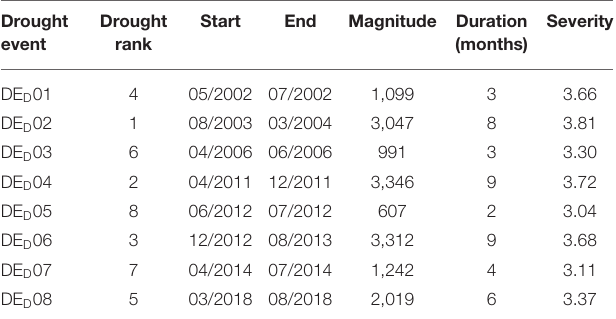
TABLE 4 | New Mexico DSCI identified Drought Events (DE D s) and drought severity since 2000. Drought Drought event